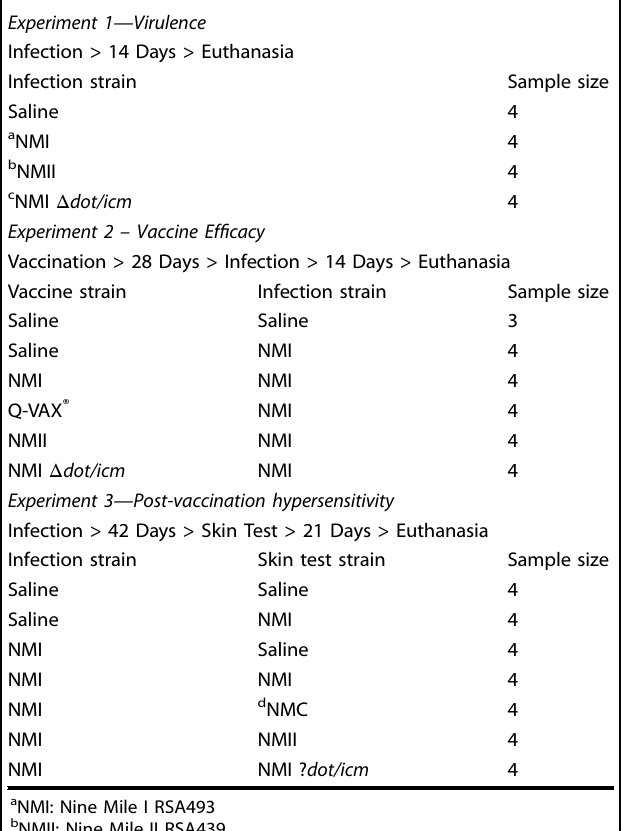
Table 1. Experimental